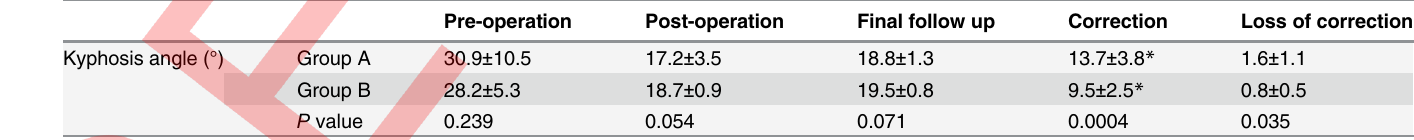
Table 4. Radiographic results (Group A and Group